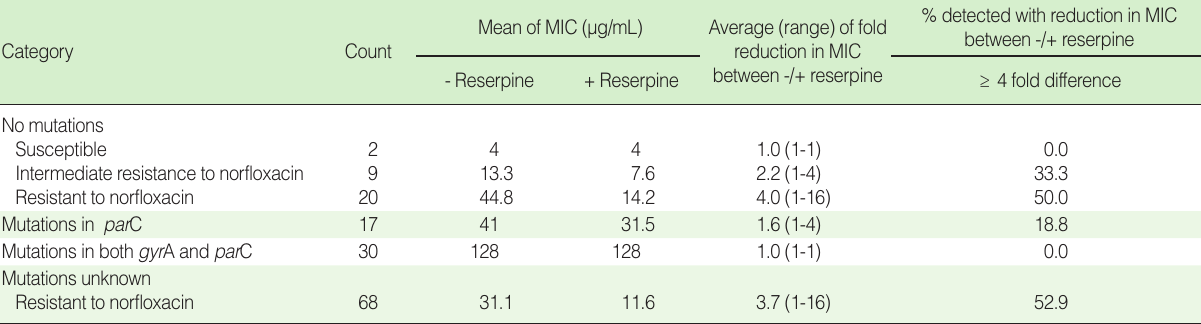
Table 2. Minimum inhibitory concentration (MIC) of norfloxacin in the presence/absence of reserpine of 146 clinical group B Streptococcus strains from South Korea (2006-2008)